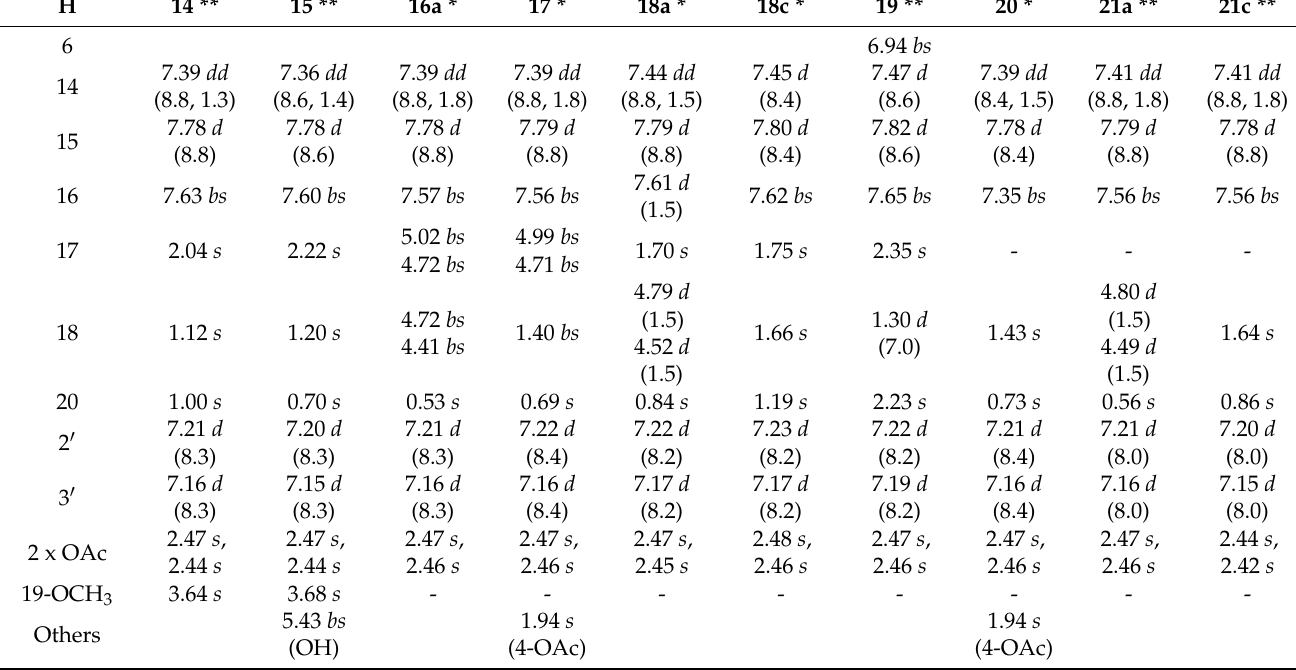
m / z . RMN 1 H: Table 4. RMN 13 C: Table 5. The mixture 18a – c was dissolved in toluene and iodine (10 mg) was added and stirred at 95 ◦ C for 3 h. The cooled mixture was evaporated and redissolved in EtOAc. The organic layer was washed consecutively with aq sat sodium thiosulphate (Na 2 S 2 O 3 ) and brine and dried over anhydrous Na 2 SO 4 , to yield 18c (96%). Table 4. 1 H-NMR data for compounds 14 – 21 ( δ ppm ( J in